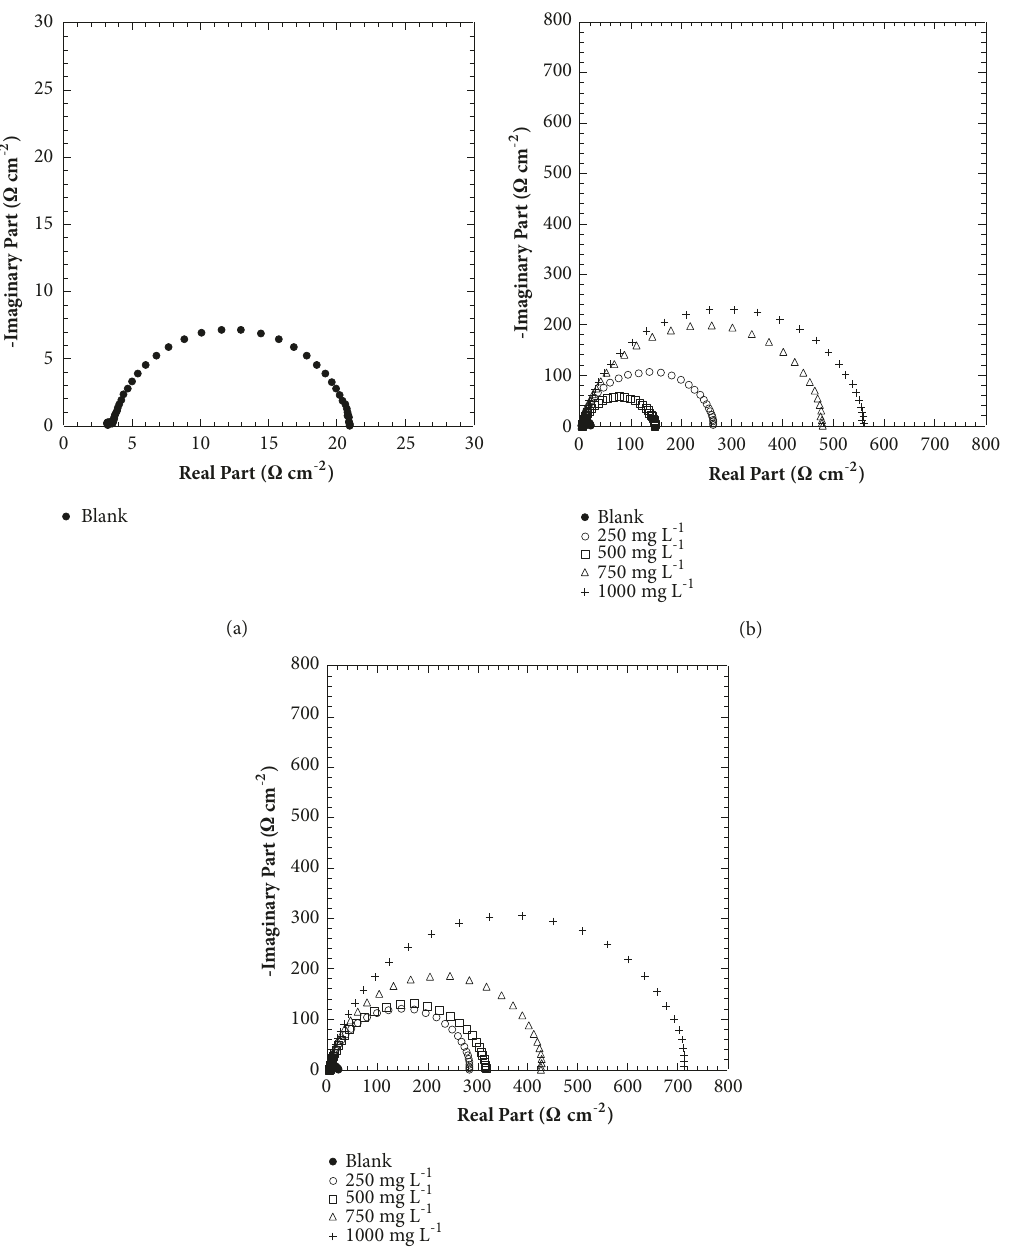
Figure6:Nyquistdiagramofcarbonsteelin1.0 molL – 1 HClsolutionwithout(a)andwithinhibitors 1 (b)and 2